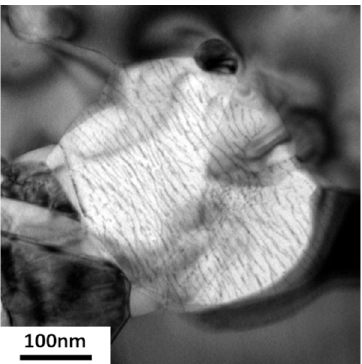
Figure 13. TEM bright field micrograph showing the dislocation arrays in γ ’ grains in 85%-rolled sample after annealing at 575 °C for 978 h.